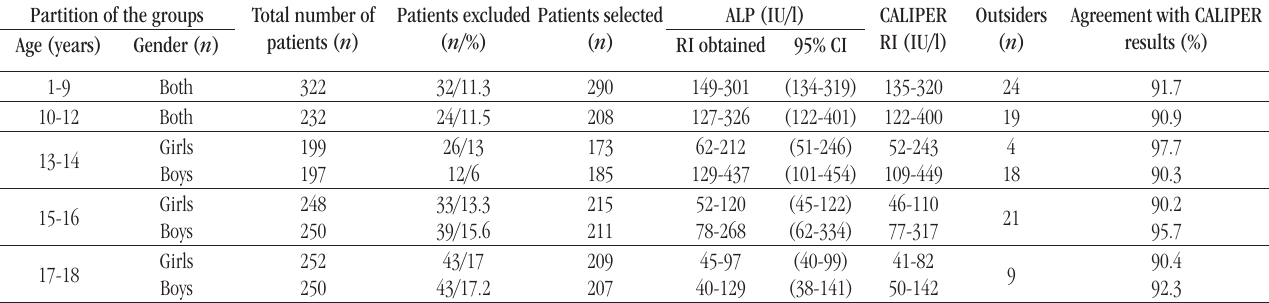
taBLE − General data of patients selected for the study, RI, CI of ALP in serum, and results of this Brazilian study compared to the CALIPER study Partition of the